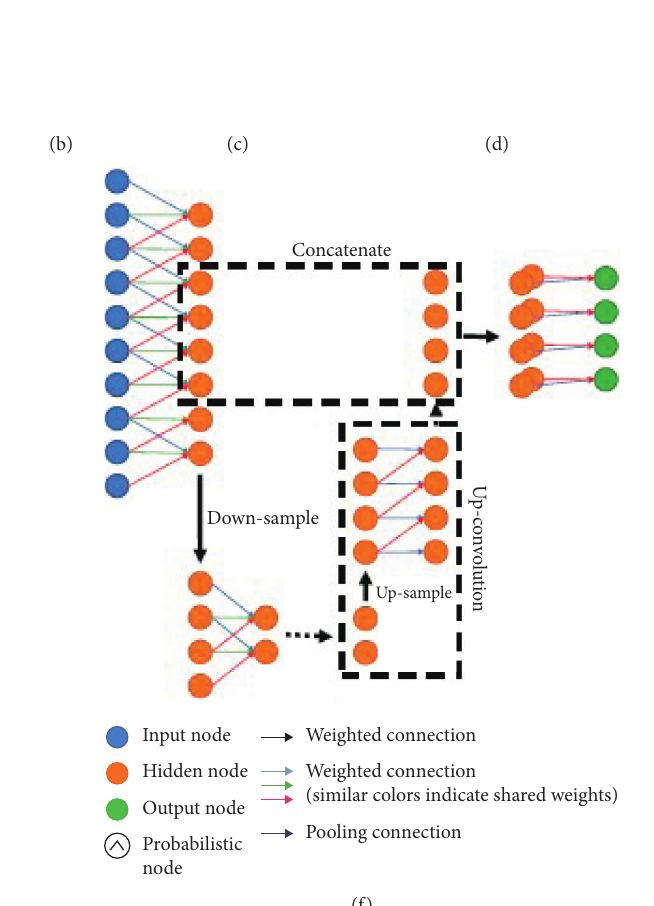
Figure 13: Representation of deep learning architectures. (a) Autoencoder. (b) Deep belief networks. (c) Recurrent neural network. (d) Convolutional neural network. (e) Multistream convolutional neural network. (f) U-net architecture